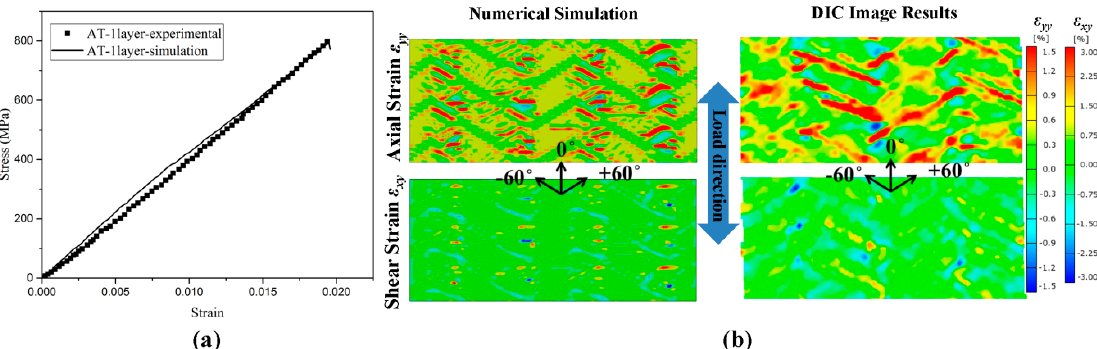
Figure 3. Comparison of the experimental and numerical predicted results for straight-side coupon specimen. ( a ) Global stress–strain curves. ( b ) Distribution of the axial and in-plane shear strain at global strain level of 2.0%.